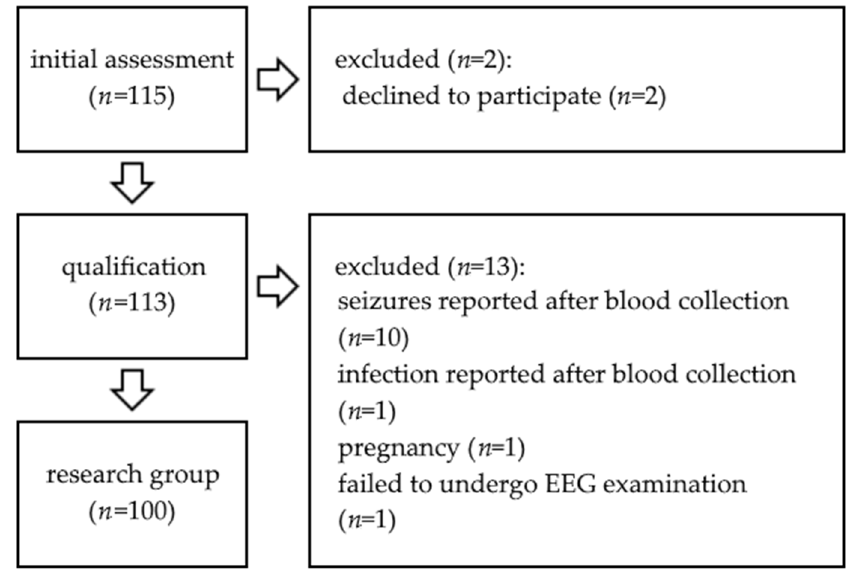
Figure 1. Study flow chart.